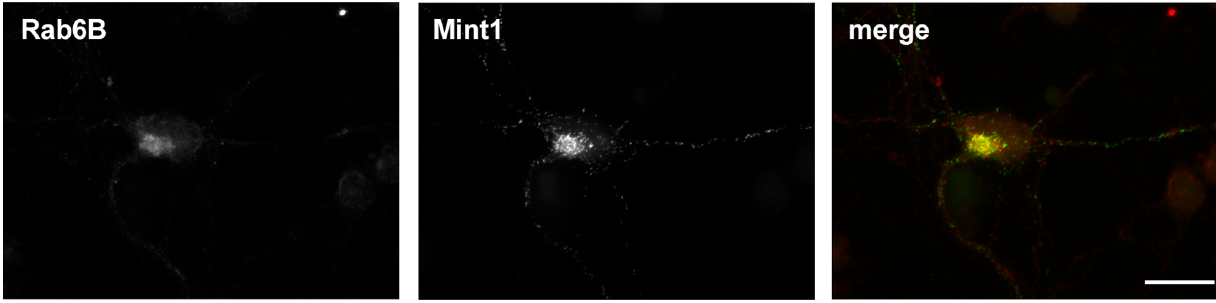
Figure 1. Co-localization studies with Rab6 and Mint1. Co-staining of Mint1 and Rab6B in primary mouse neurons. Cells were treated with anti-Mint1 and anti-mouse Alexa488 as well as anti-Rab6B and anti-rabbit Alexa594 antibodies. Scale bar: 20 m m.